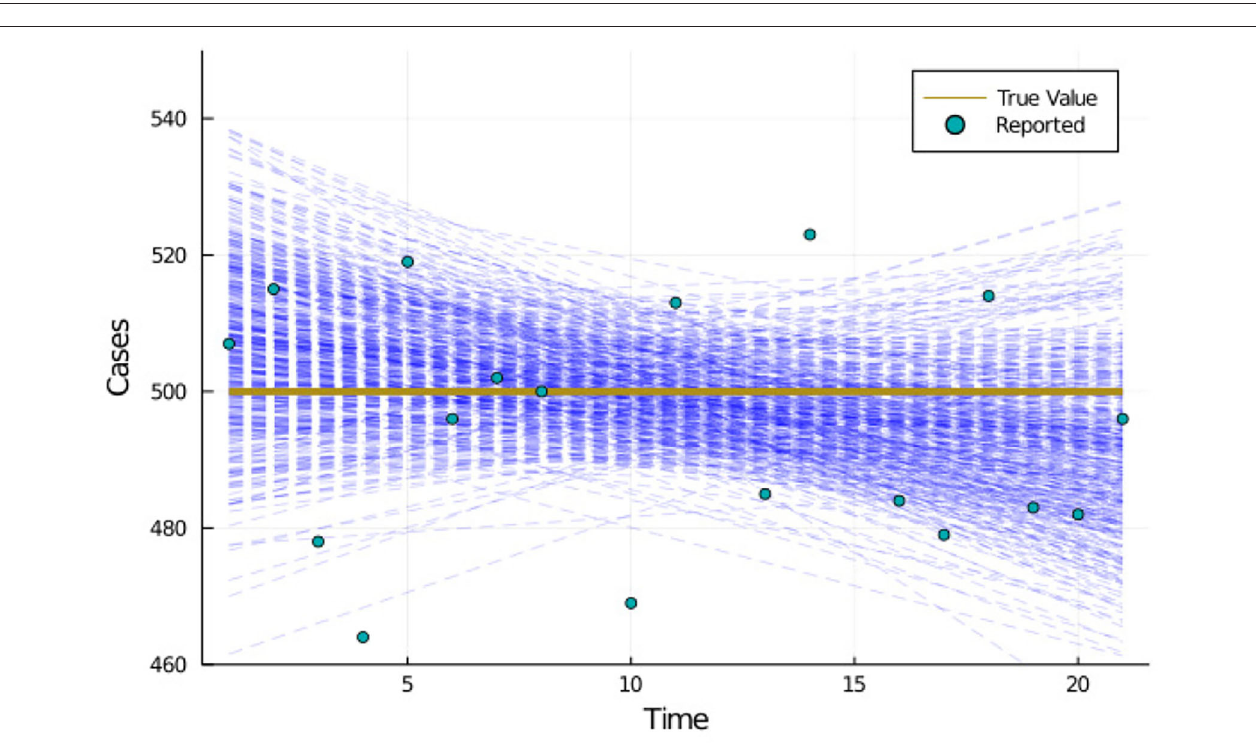
FIGURE 2 | Synthetically generated test case illustrating why calculated confidence near the beginning and end of a window may tend to overpredict their range.